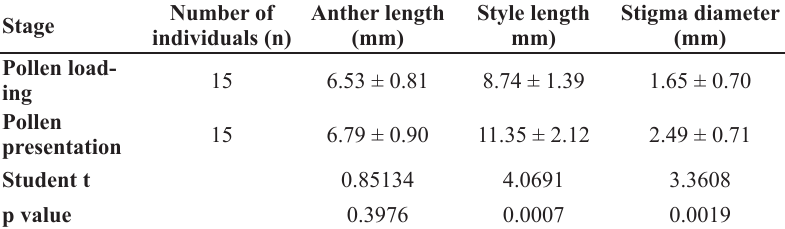
Table 2 – Morphological measurements (mean ± standard deviation) of pistil and stamen in flowers of Campanula vardariana at the pollen loading and presentation stages.